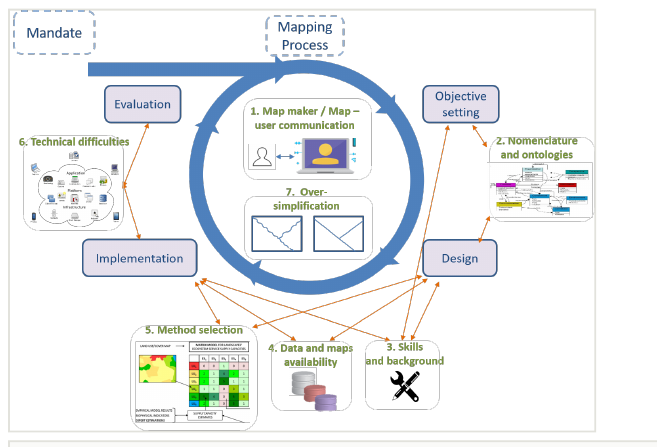
Figure 1. Ecosystem service (ES) bottlenecks in ES mapping along the planning cycle. Modi fi ed from Liu and Opdam (2014). Several bottlenecks can emerge in di ff erent phases of the mapping process or continously through it as bottlenecks 1 and 7.